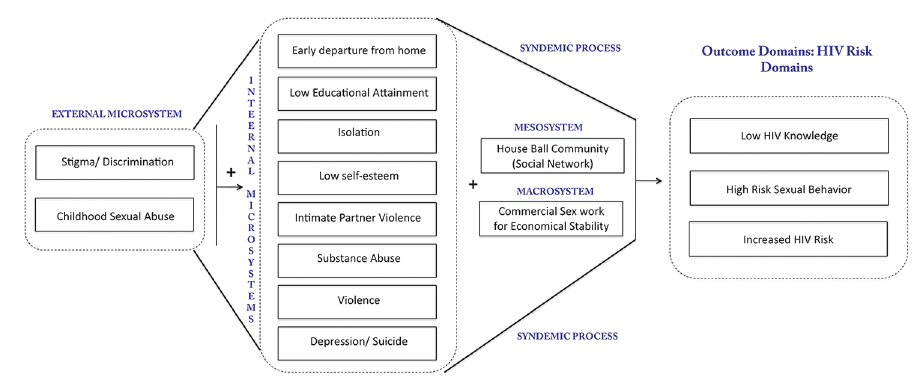
Figure 1: Syndemic process of influential systems that create an environment for increased HIV risk in members of the